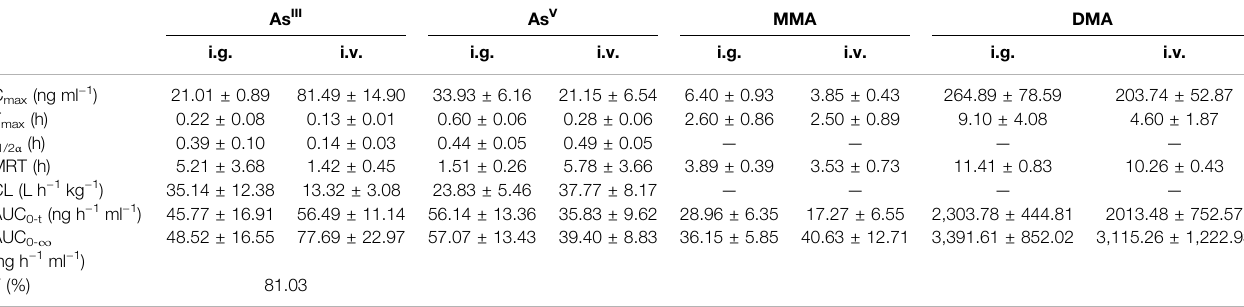
TABLE 1 | Pharmacokinetic parameters of arsenic metabolites after a single intragastrical (i.g.) and intravenous (i.v.) administration of 1 mg kg − 1 ATO in rats. As III As V MMA